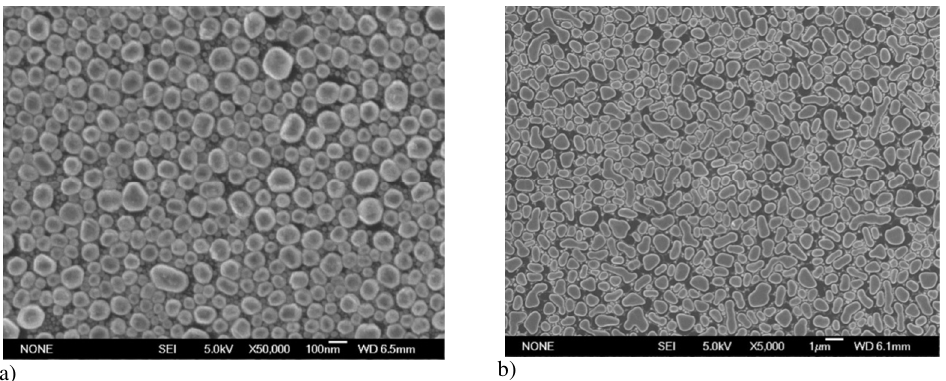
Fig. 1. SEM image of the catalysts for the synthesis of silica nanowires: a) indium, b)